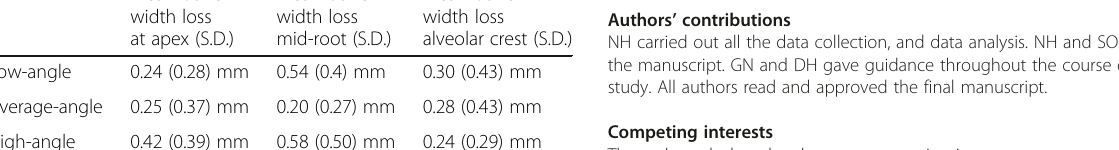
Table 3 Summary of mean bone loss at the apex, mid-root, and alveolar crest in low-, average-, and high-angle patients Mean bone width loss at apex (S.D.) mid-root